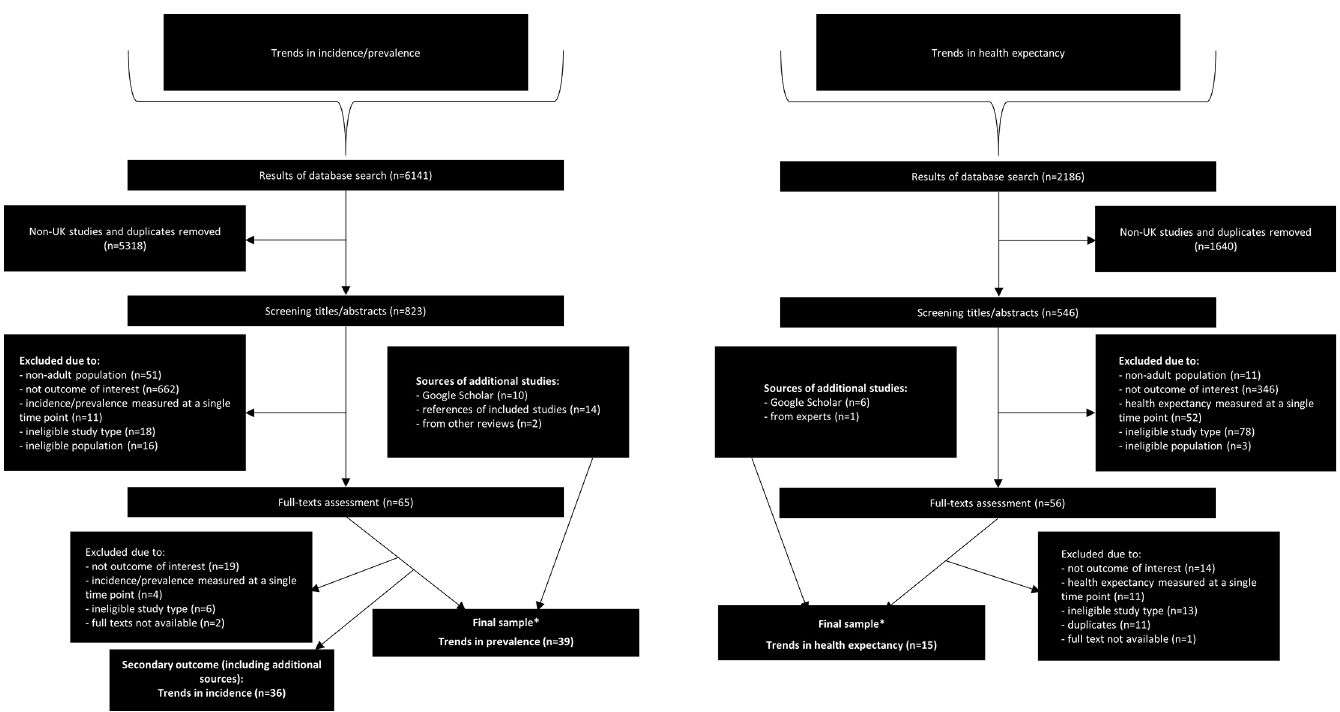
Fig 1. Flow chart for selection of papers and sources included in the review. � One study reported both prevalence and health expectancy.